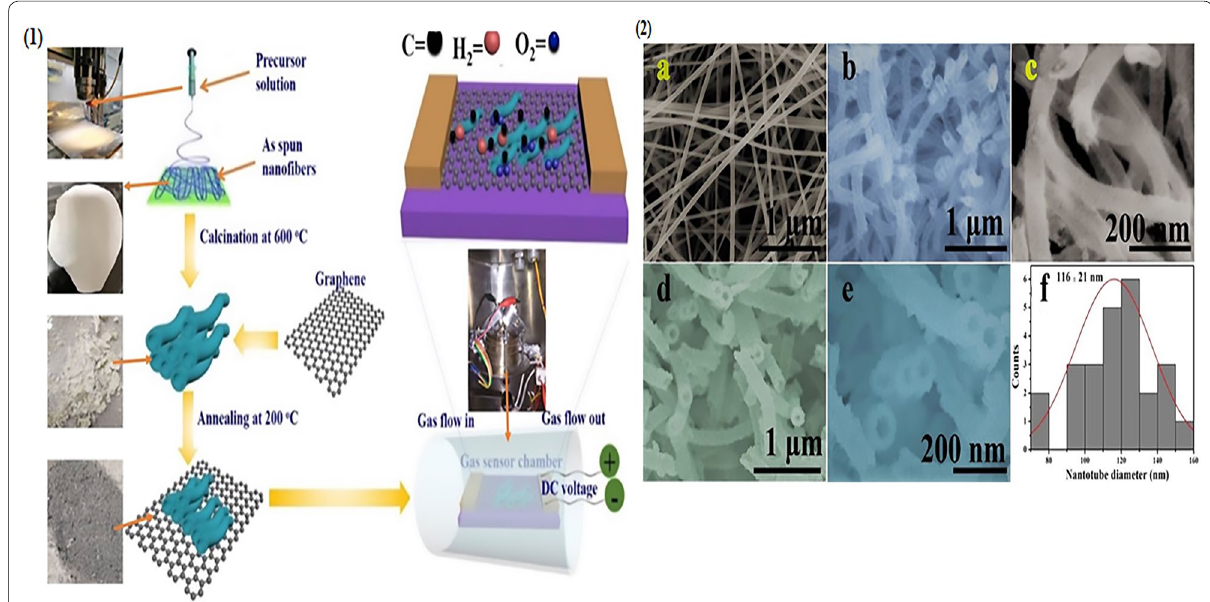
Fig. 2 (1): Pristine and GO‑SnO 2 NTs preparation and gas sensor mechanism and (2) SEM images of ( a ) as‑prepared Sn (PVP) nanofibers ( b , c ) pristine SnO 2 , and ( d , e ) GO incorporate SnO 2 NTs, ( f ) Histogram of GO‑SnO 2 NT diameters Reproduced with permission